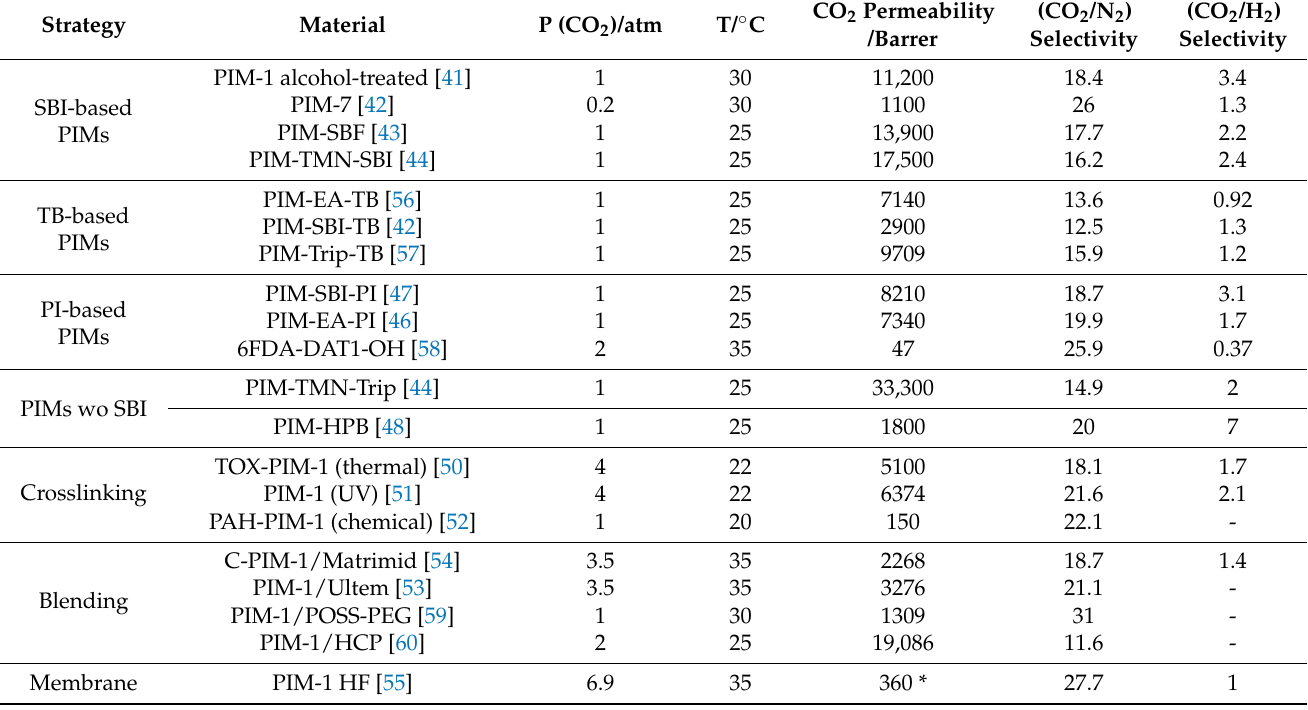
Table 4. Transport properties of specific